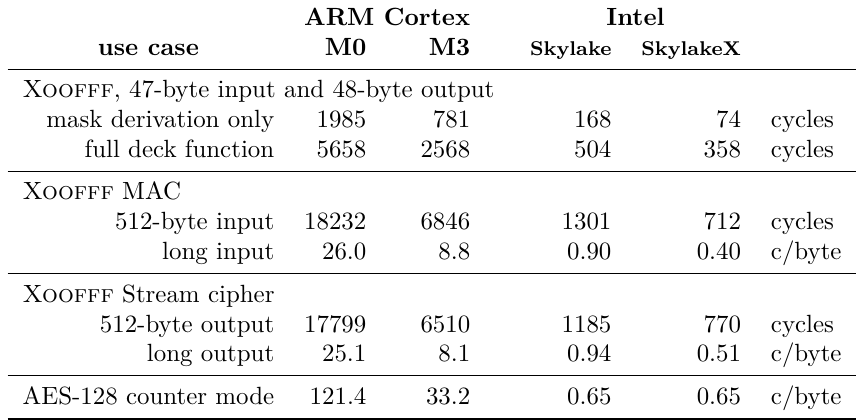
Table 5: Performance of Xoofff on different platforms. The AES figures on Cortex-M0 and -M3 come from [Log, SS]. Skylake refers to an Intel R (cid:13) Core TM i5-6500 processor at 3.2GHz and SkylakeX to an Intel R (cid:13) Core TM i7-7800X processor at 3.5GHz. In both cases, the benchmark was performed with the Turbo Boost feature